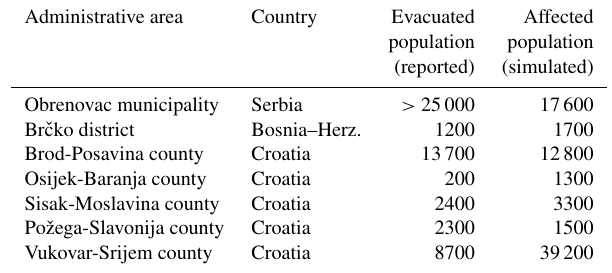
Table 5. Comparison of evacuated population (reported) and af- fected population (simulated) in administrative areas in Bosnia– Herzegovina, Croatia and Serbia (source: ILO, 2014; ICPDR and ISRBC, 2015; Wikipedia,